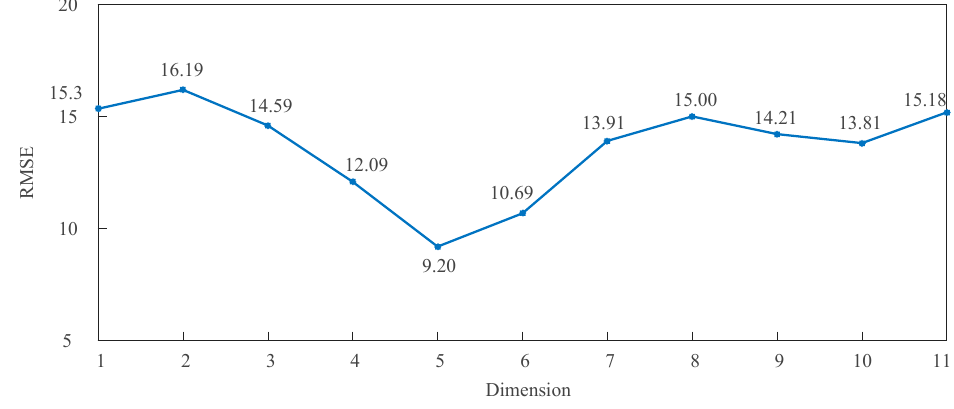
Figure 3. Correlation between different variables and PM 2.5 .